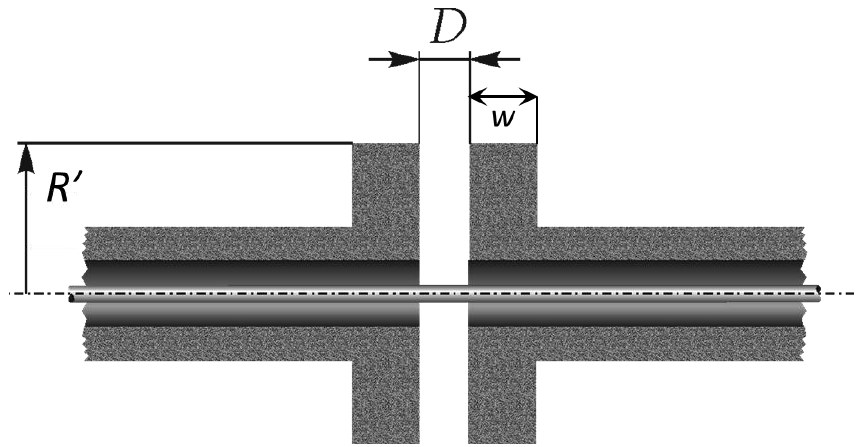
Figure 3. Proposed adiabatic gap scheme in transmission line .